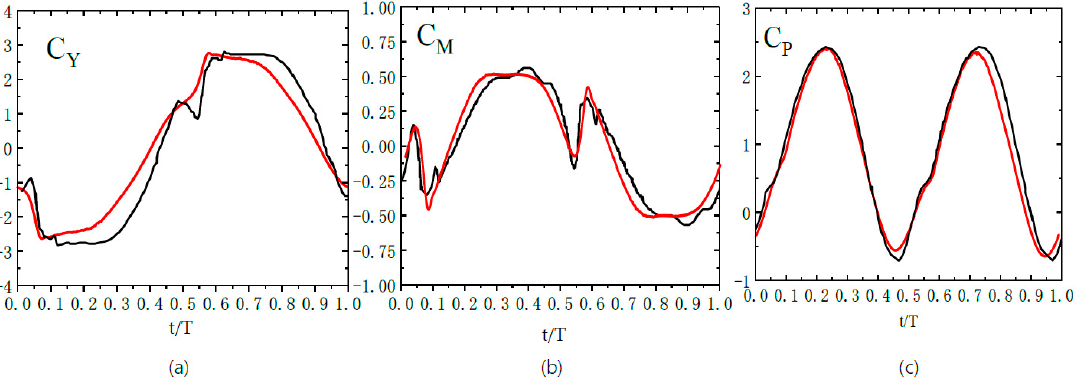
Figure 5. Comparison of lift, momentum and power coefficient in the same cycle at f * = 0.14 (the solid red lines show simulation results with the Spalart-Allmaras (SA) model and the solid black lines show results from Reference [8]). ( a ) Lift coefficient. ( b ) Momentum coefficient. ( c ) Power coefficient.